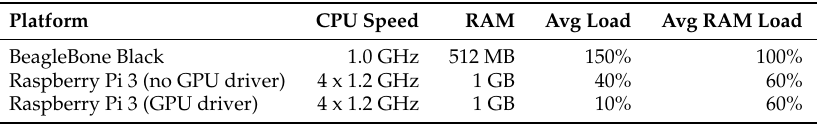
Table 3. Machine